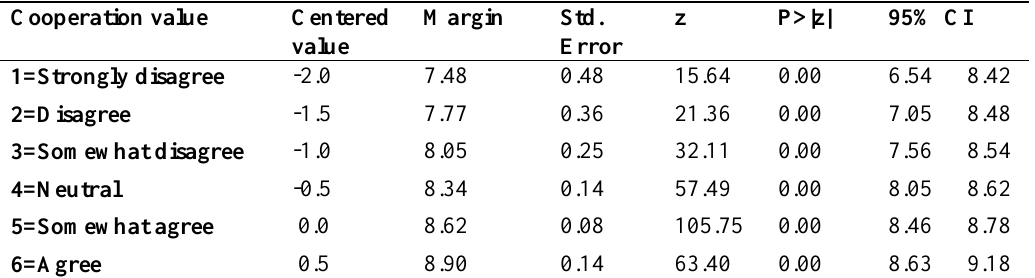
Table A1.3 Statistical significance for the predicted values (margins) of perceived success by levels of cooperation Cooperation value